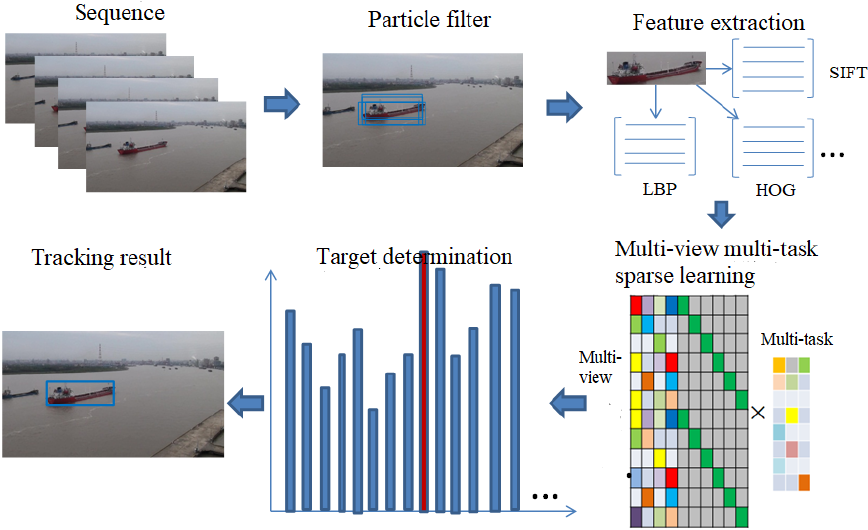
Figure 1. Target identification schematic of multi ‐ view multi ‐ task